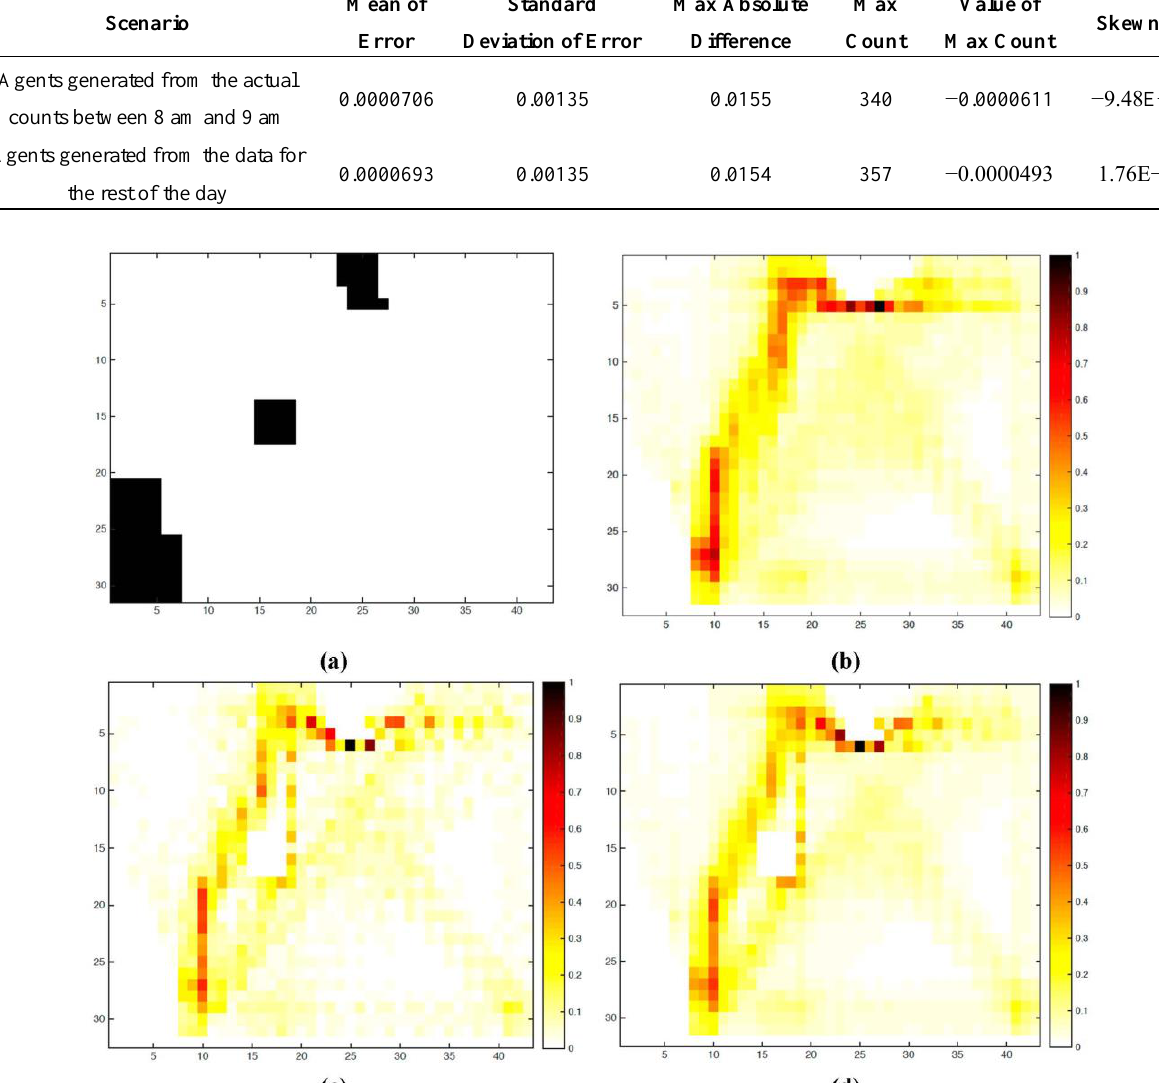
Figure 12. ( a ) Obstacles (black squares) added to the scene; ( b ) Heat map of increased traffic without obstacle; Normalized heat maps for low ( c ) and high ( d ) volumes of